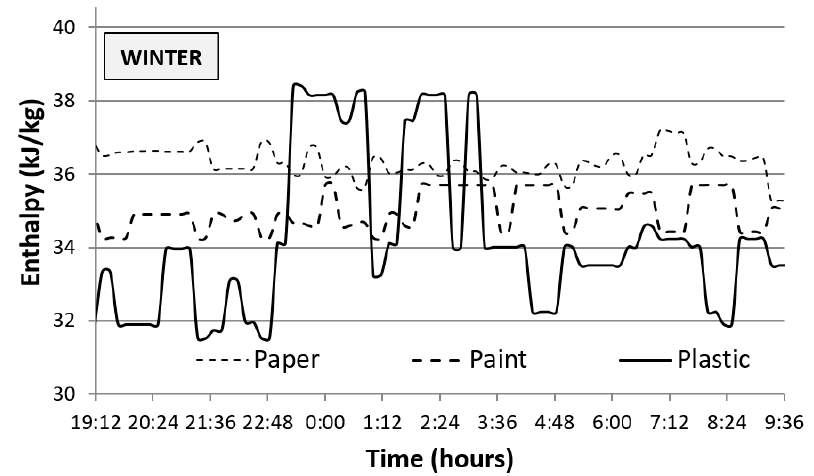
Figure 7. Indoor air percentage of dissatisfied persons (PD IAQ ) predicted for each internal covering during the winter season.